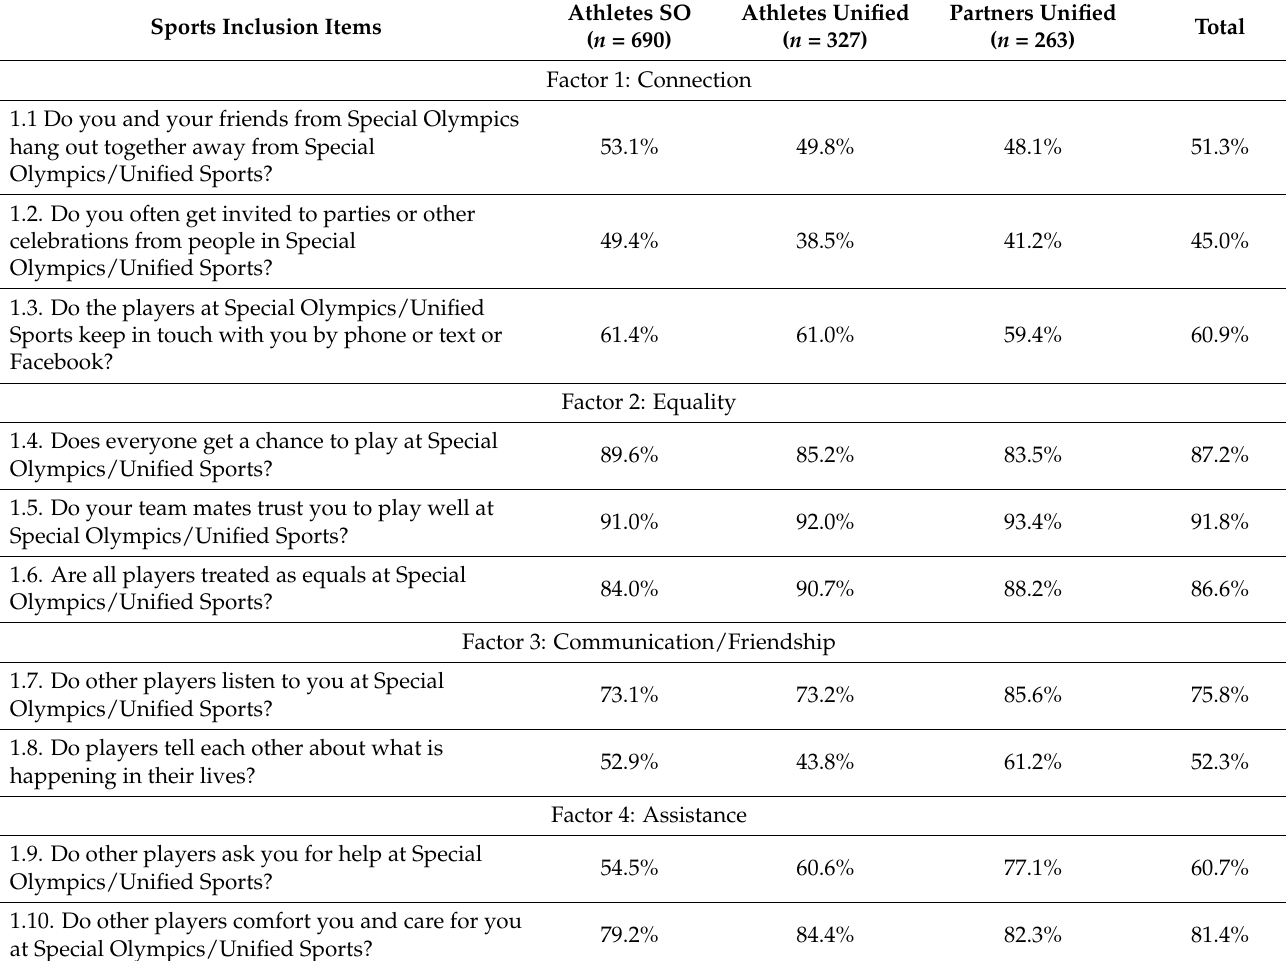
Table 4. The percentage of athletes and partners answering ‘Yes’ to the Sports Inclusion Items. Sports Inclusion Items